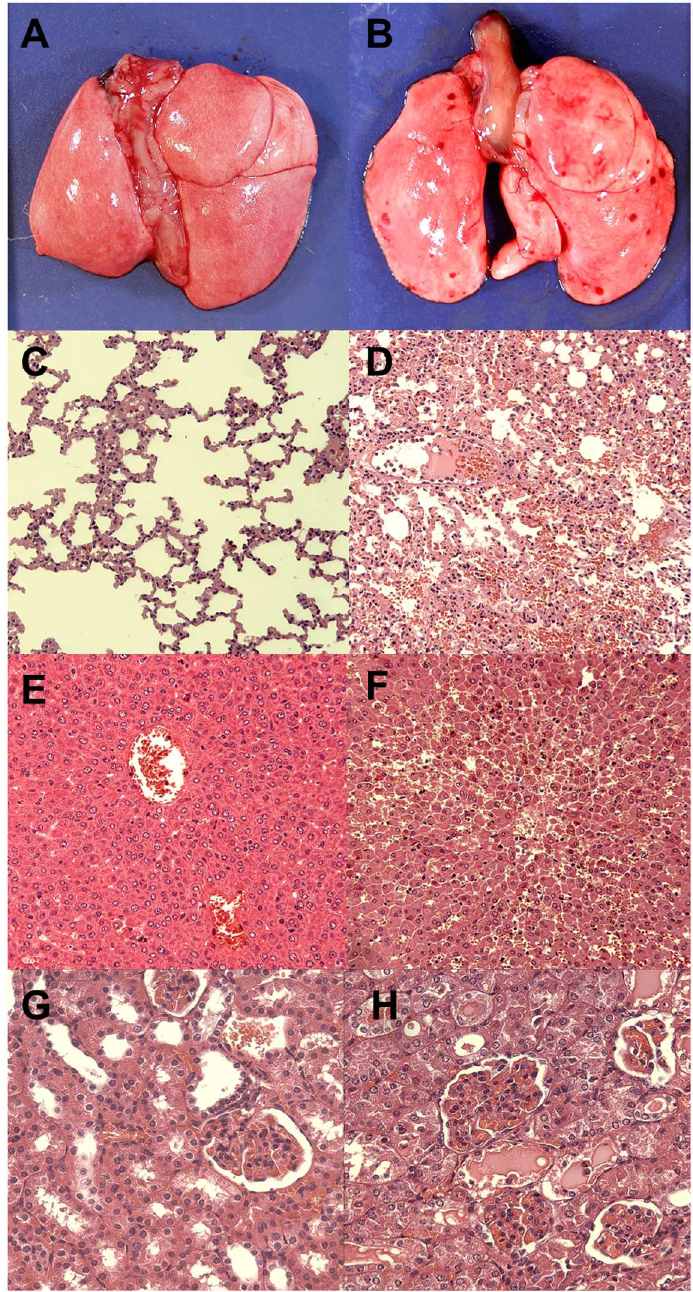
Fig 3. Pathological findings in the hamstermodel. Animals vaccinated with rLigB(131–645)(A, C, E and G) or the PBS control group (B, D, F and H) were euthanized10 days PC and tissue samples were collected. Vaccinated animalsshowedno gross pulmonarylesions (A) or microscopicpulmonary lesions(C). Liver (E) and kidney samples (G) showedno evidenceof microscopicabnormalities. Unvaccinated animals showed gross pulmonaryhaemorrhaging (B) and they were confirmedto be alveolarhaemorrhages by microscopic analysis(D). Dystrabeculaton (loss of cohesion)of hepatocytes(F) and swellingof kidney tubularepithelial cells (H) were prominent features. (C-F, haematoxylin-eosin,100 × magnification and G-H, haematoxylin- eosin, 200 ×